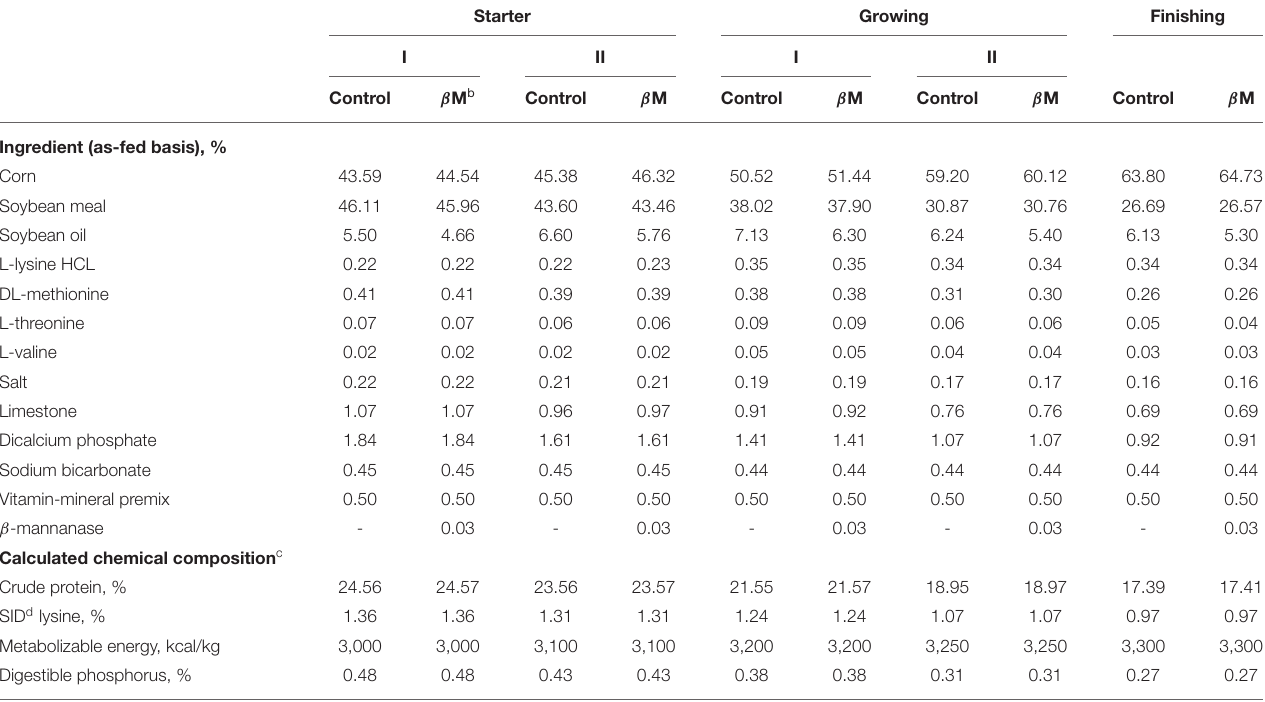
TABLE 4 | Composition of broiler feeds a